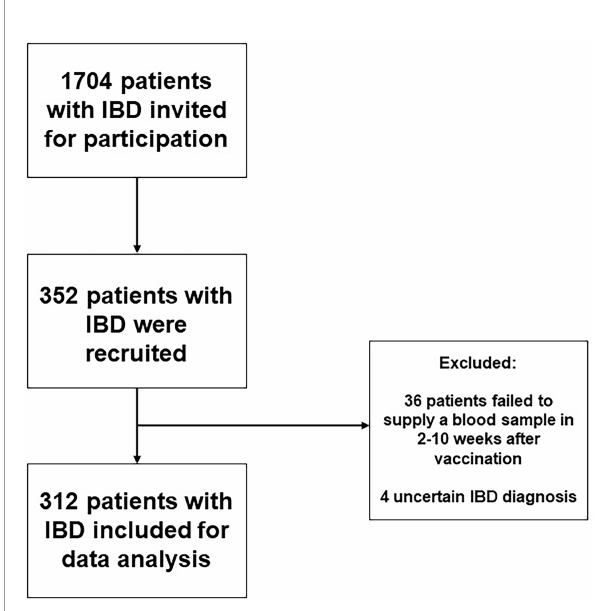
FIGURE 1 | Flow chart of the study showing the participant inclusion